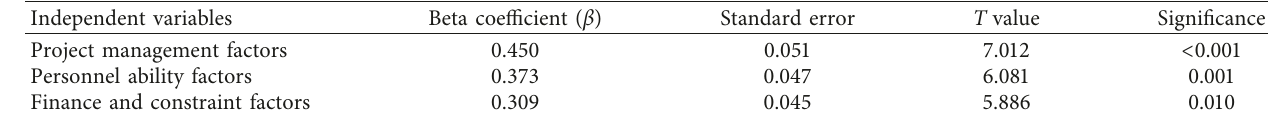
Table 6: Stepwise multiple regression